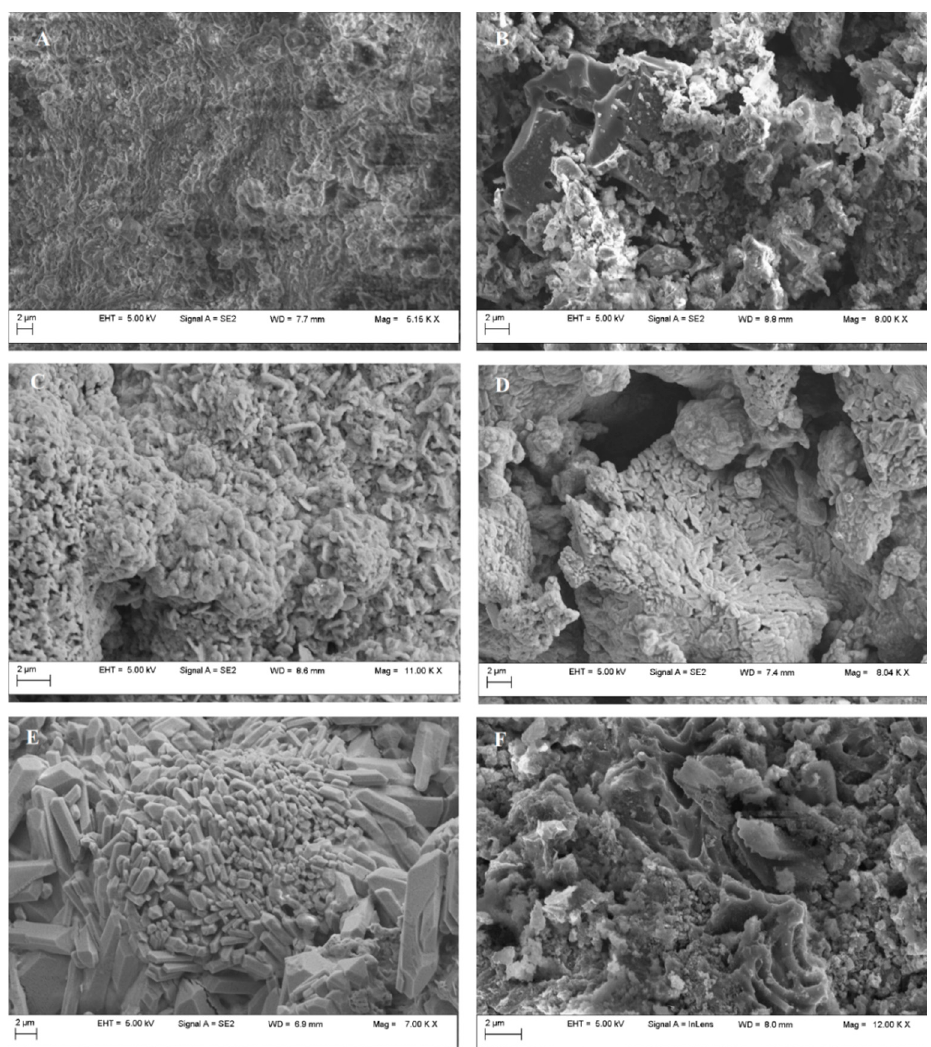
Figure 3. SEM microphotographs of dried sewage sludge ( A ), SS PYCHAR ( B ), I_1 ( C ), I_2 ( D ), I_3 ( E ) and I_4 ( F ).